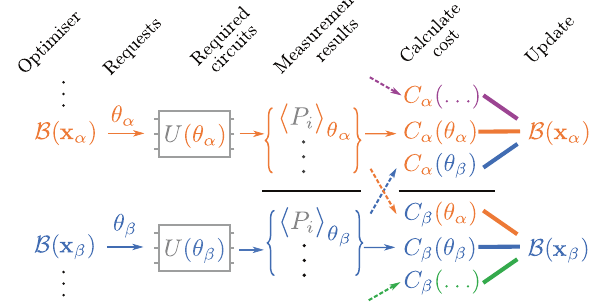
Fig. 1 Information sharing framework. Parallel Bayesian optimisa- tion for physically parameterised VQE tasks. Separate BO ’ s Bð x α Þ optimise for different cost functions C α , corresponding to different values of the physical parameters x α , using the same parameterised ansatz circuit U ( θ ). Every iteration, each Bð x α Þ requests a new variational parameter point θ α , at which the set of Pauli strings { P i } are measured. These expectation values are used to compute any C β cost functions (dashed lines) at θ α , for all α , β . Each BO can then be updated using the measurement results obtained for several θ α , θ β , … parameter points each iteration (bold arrows), dramatically speeding up convergence at all x α .